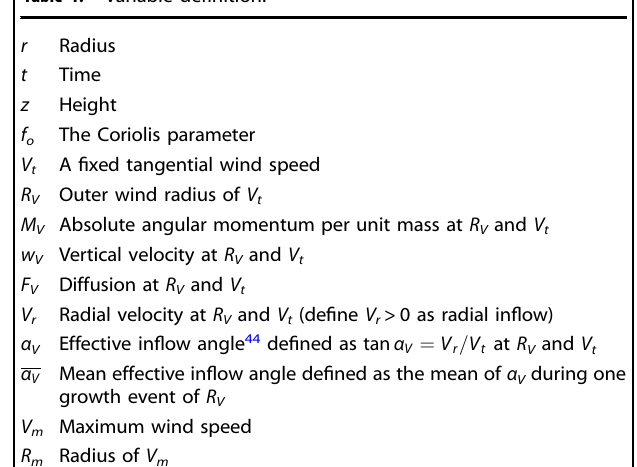
Table 1. Variable de fi